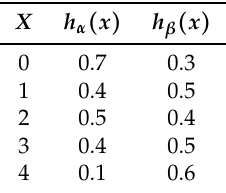
Table 4. Tabular representation of h = ( h α , h β )